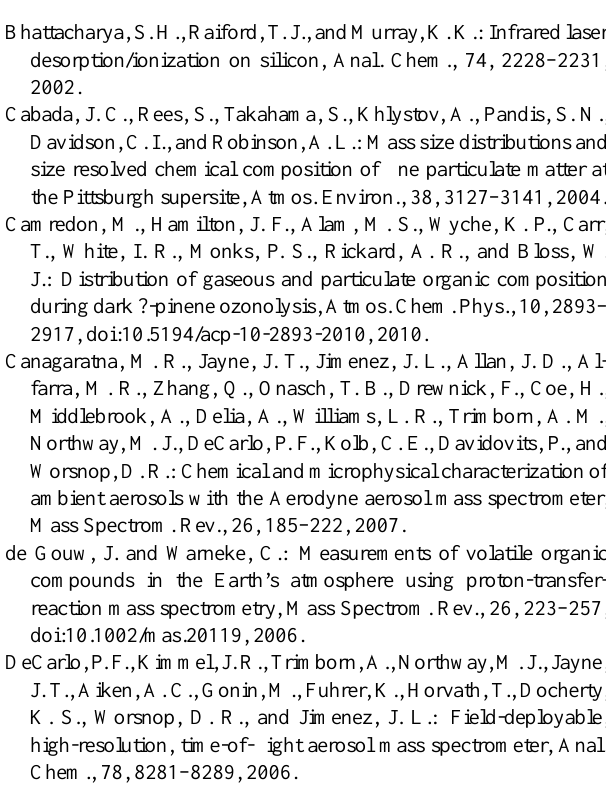
(  ) 183 m/z ; (  ) 199 m/z ;